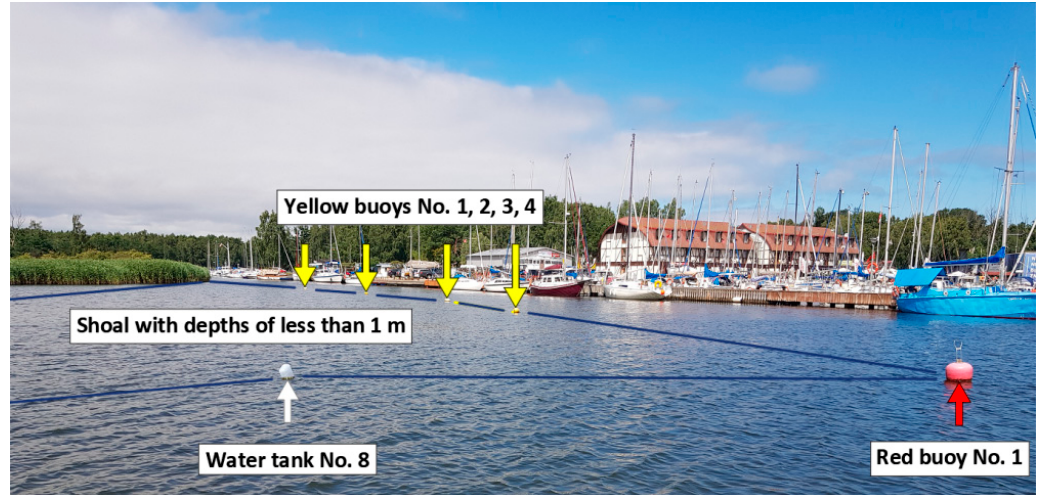
Figure 9. Navigation marks on the shoal in the vicinity of Green Islands.